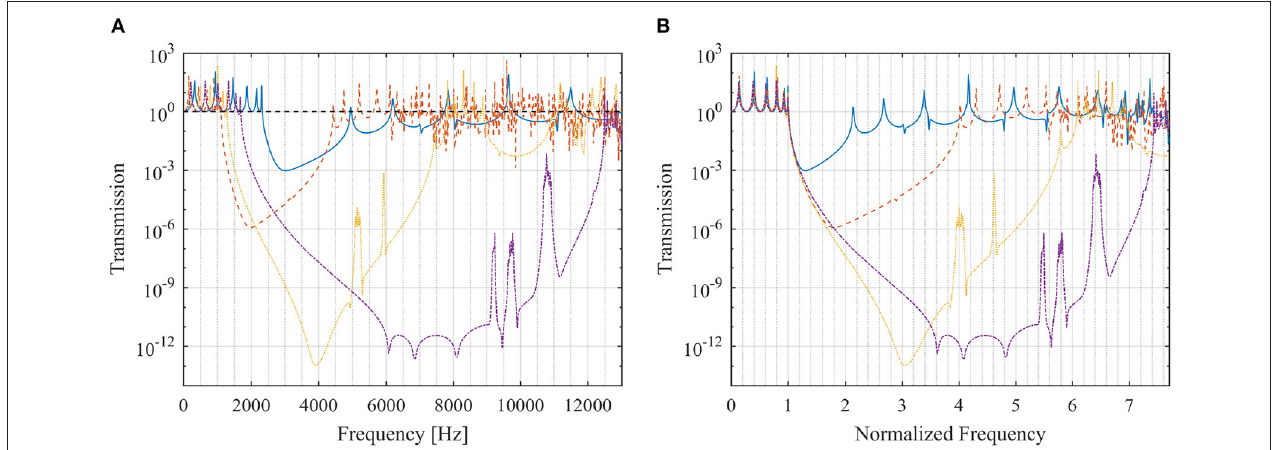
FIGURE 7 | Frequency-dependent transmission for the cubic (blue solid), idealized foam (red dashed), Kelvin (yellow dotted) and octet (purple dashed-dotted) metastructures with lattice relative density equal to 8.3%. (A) Transmission vs. frequency. (B) Transmission vs. normalized